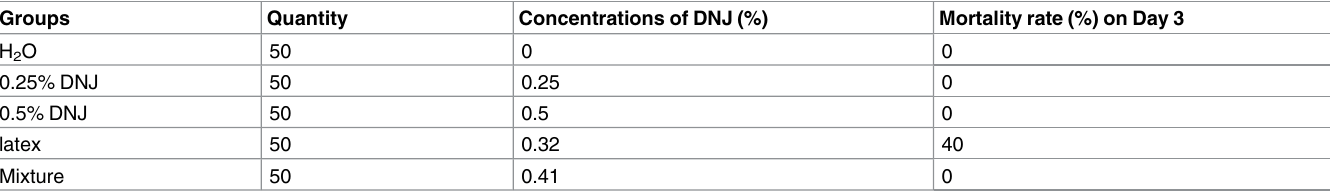
Table 1. Concentrations of DNJ in five groups of four-instar S . cynthia ricini and their mortality rate, respectively.